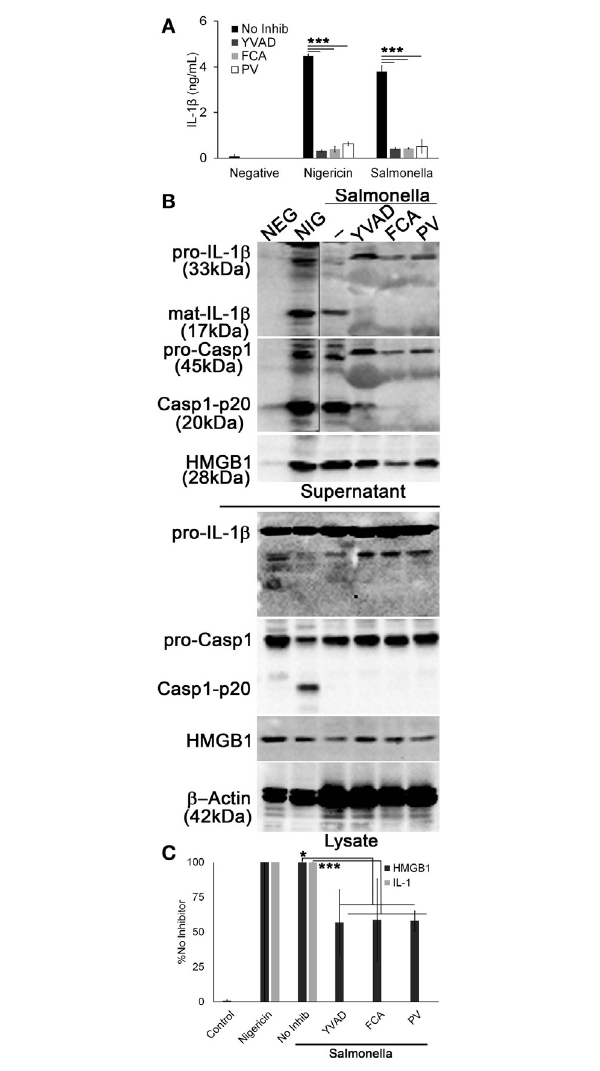
FigUre 6 | Salmonella -induced il-1 β release requires Dnase1l3 activity . Lipopolysaccharide-primed BMDM were treated with or without 100 µM YVAD, 100 μ M fmoc- d -cyclohexylalanine (FCA), and 50 µM pontacyl violet 6R (PV) followed by Salmonella (MOI 50) for 1 h or 20 µM nigericin for 30 min. (a) IL-1 β in supernatants was detected by ELISA. (B) Proteins from trichloroacetic acid-precipitated supernatants and cell lysates were resolved by SDS-PAGE and transferred to nitrocellulose. High-mobility group box 1 protein (HMGB1), caspase-1 (Casp1), IL-1 β , and β -actin were detected by western blot. (c) The levels of mature IL-1 β in the supernatant were ratioed to pro-IL-1 β levels in the cell lysates, or levels of secreted HMGB1 were ratioed to HMGB1 in the lysate, and all expressed as a percentage of B6 BMDM treated with Salmonella and no inhibitor. Graphs are mean ± SEM of four independent experiments, while immunoblots are representative of four independent experiments. * p < 0.05 or *** p < 0.001 for Salmonella with inhibitors compared to Salmonella no inhibitor.